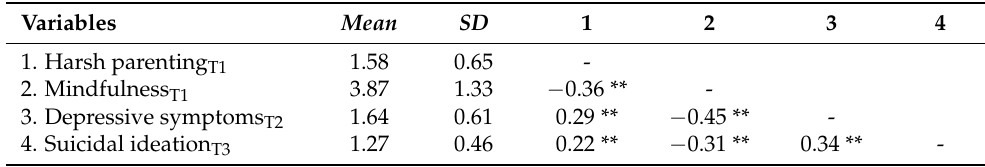
Table 1. Means, standard deviations, and